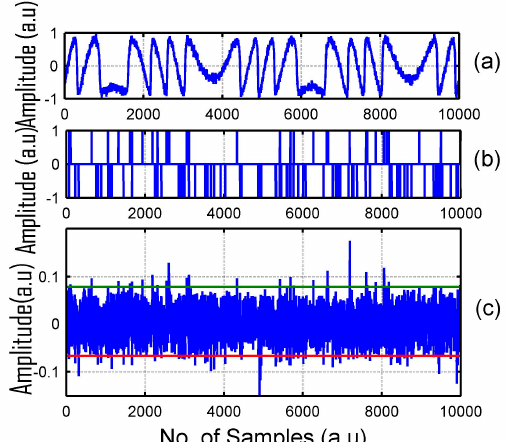
Figure 2. Performance of DBT method in case of: ( a ) noisy SM signal, and ( b ) incorrect fringe detections because ( c ) presence of noise within the derivated noisy SM signal (blue curve) makes it impossible to correctly apply thresholds (green and red straight